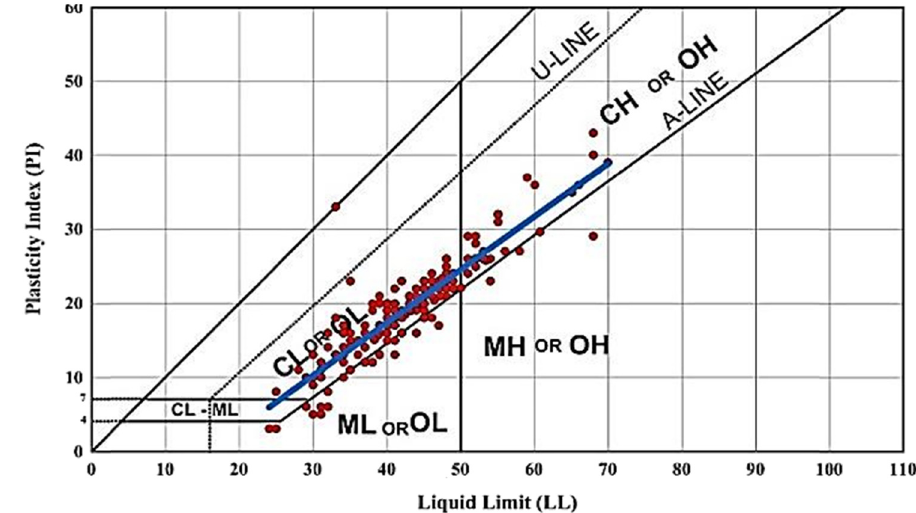
Figure 6: Plasticity chart for the soil samples according to ASTM D2487.